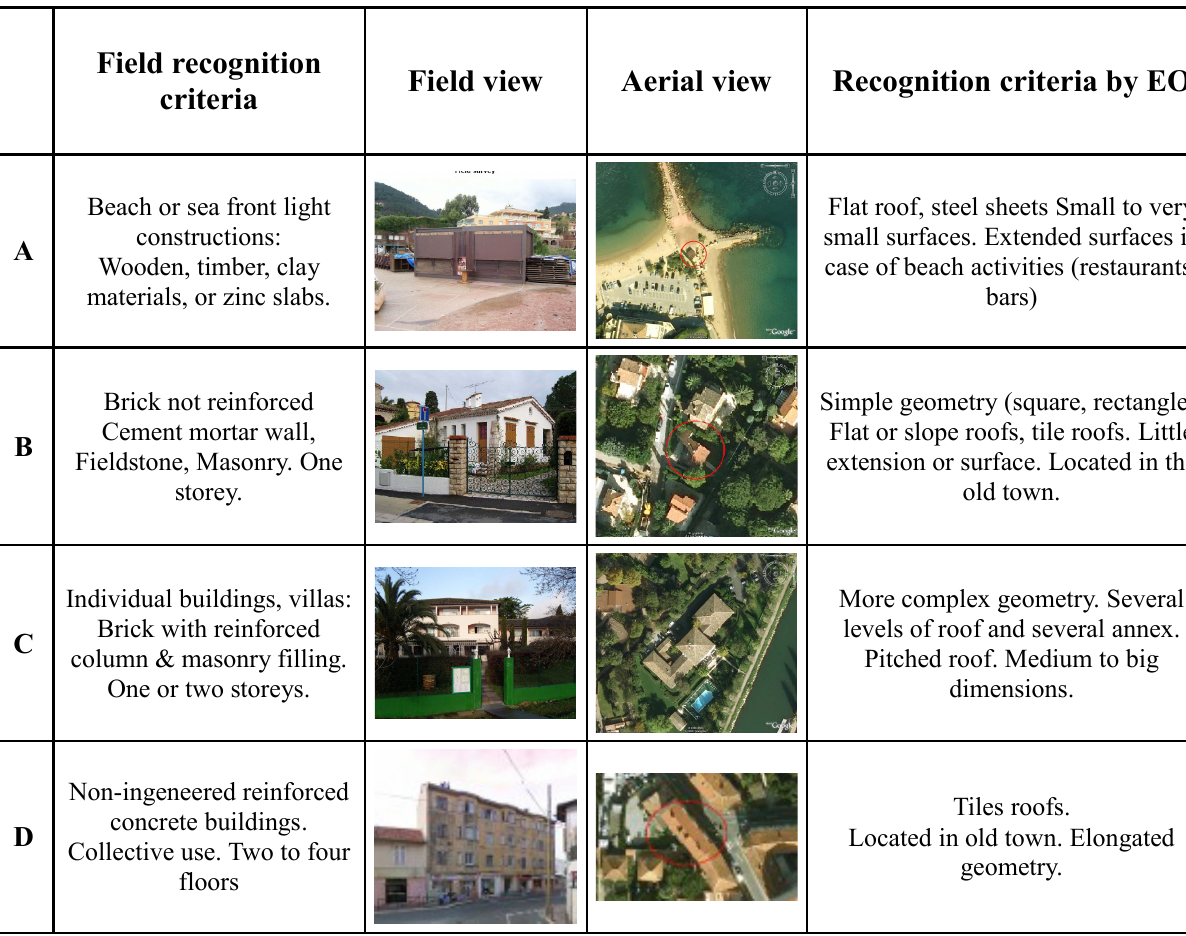
Fig. 10. Building typology depending on the resistance capacity of the constructions for Mandelieu test site (adapted from Leone et al., 2010; Peiris, 2006; Saatciouglu et al., 2006; Ghobarah et al., 2006; Reese et al., 2007). Only the classes for which we developed damage functions are shown